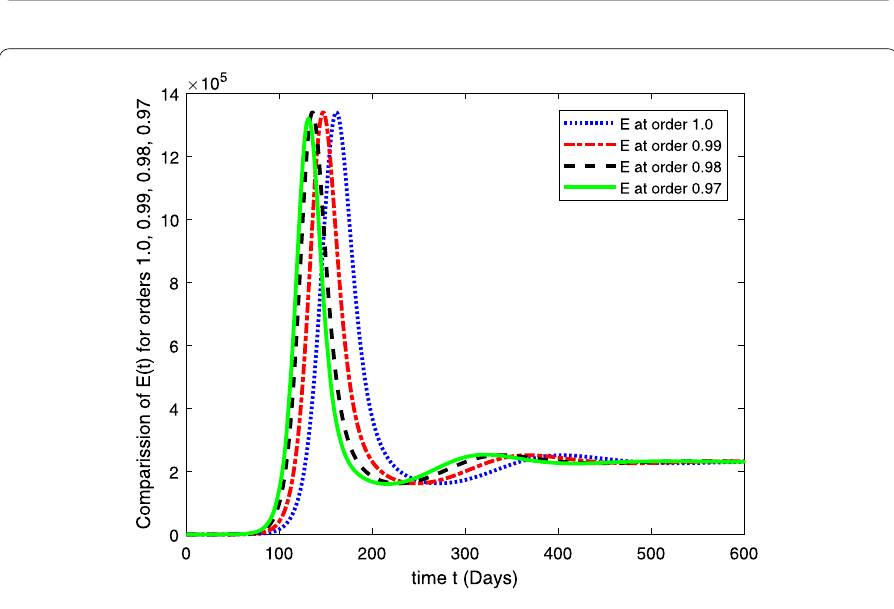
Figure 6 A comparative analysis of E ( t ) for the fractional orders 1.0, 0.99, 0.98, 0.97